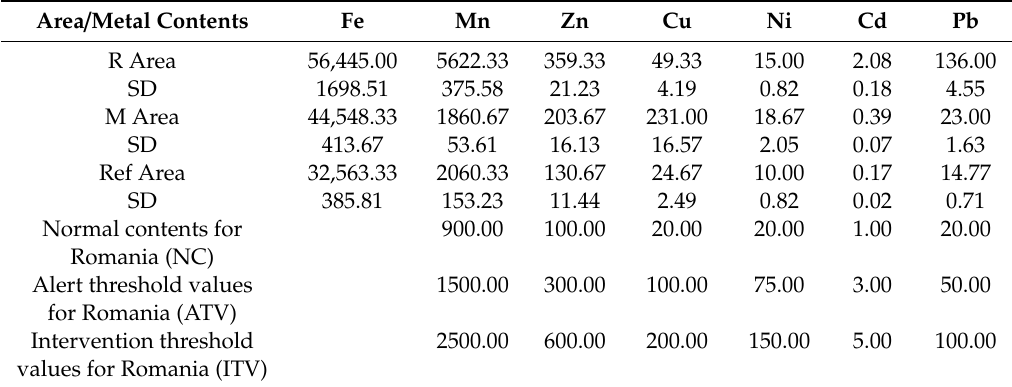
Table 1. Average soil-metal levels (mg / kg) with SD in investigated areas and national limits for these metals